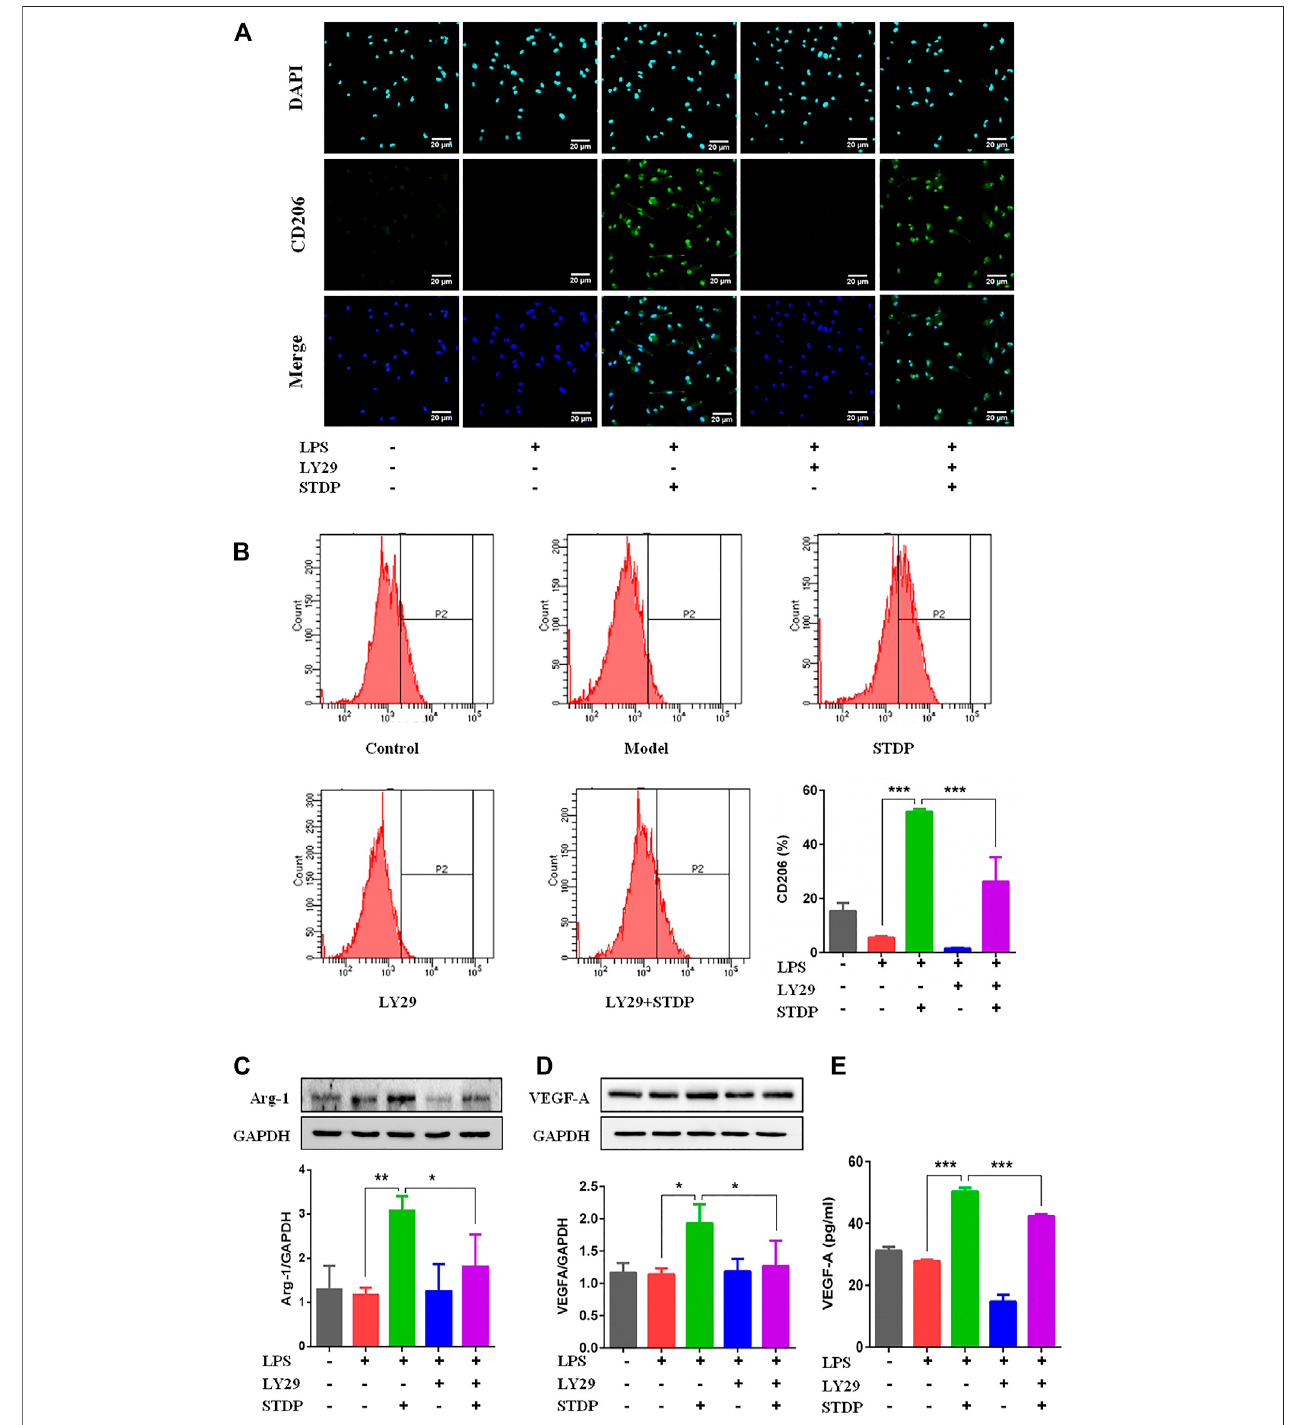
FIGURE6| STDPsmodulatedM2macrophagepolarizationandincreasedVEGF-Arelease. (A) IFstainingofCD206inthedifferentgroups.Scalebar = 20 μ m. (B) Flow cytometry results showed that CD206-positive cells were upregulated after STDP treatment. N = 3per group. (C,D) Representative immunoblotsand analysis for Arg-1 and VEGF-A in different groups. N = 3 per group. (E) The release of VEGF-A in BMDM supernatant detected by ELISA. N = 3 per group. * p < 0.05, ** p < 0.01, *** p < 0.001.